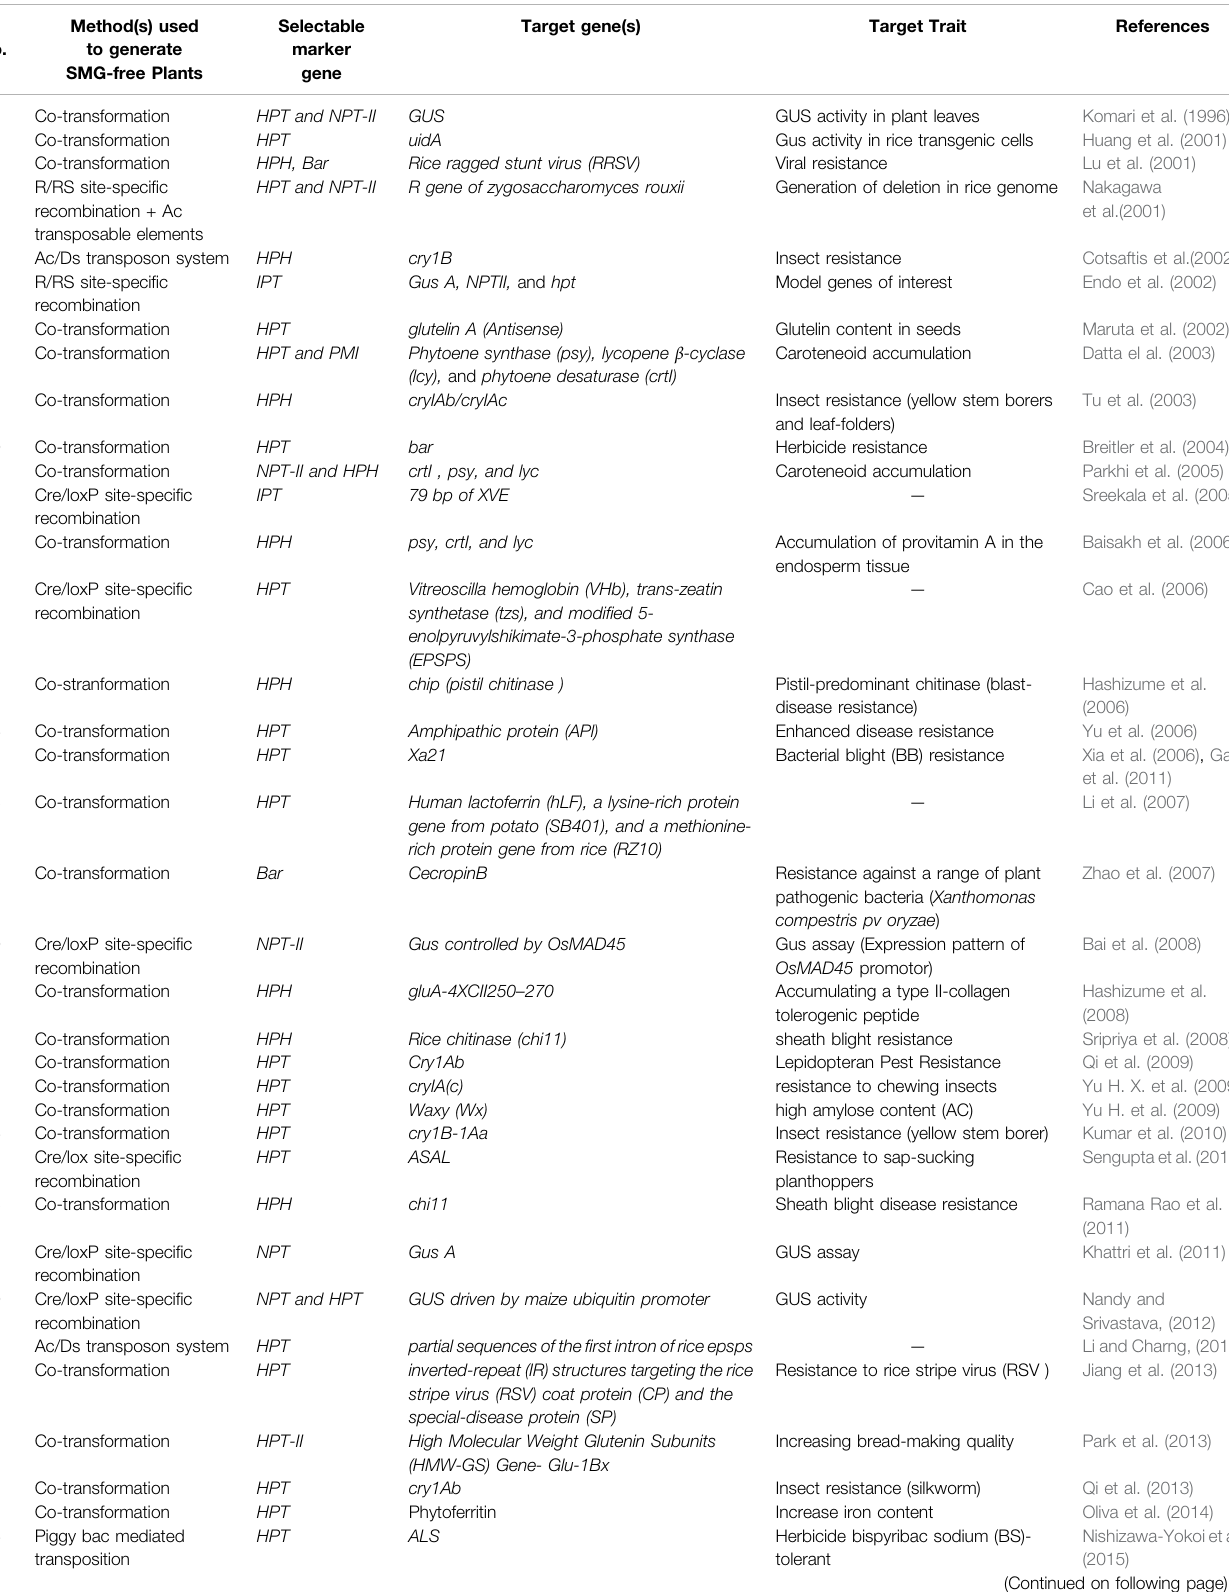
TABLE 1 | Summary of selectable markers and techniques used to create SMG-free engineered rice. S.